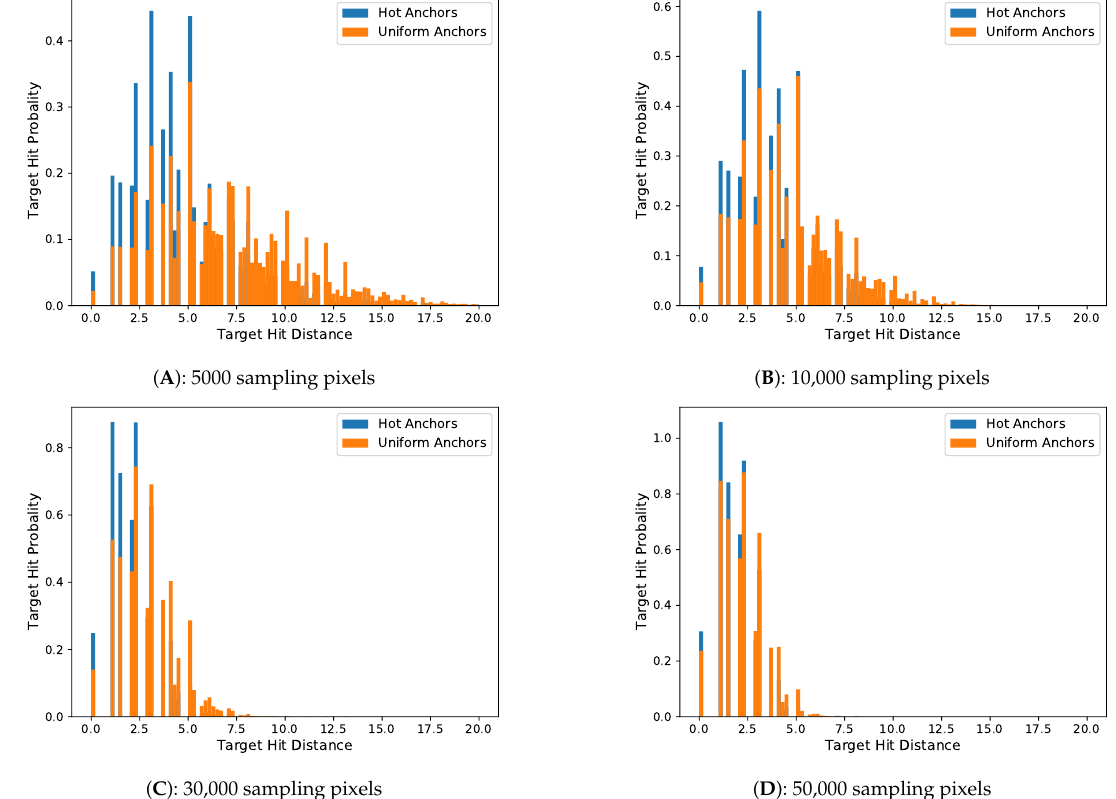
Figure 5. The hit distance histogram with different number of sampling pixels. The figures ( A – D ) have 5000, 10,000, 30,000, and 50,000 sampling pixels, respectively. The distribution of hot anchors is always closer to Y -axis than the uniform anchors when the number of sampling pixels is the